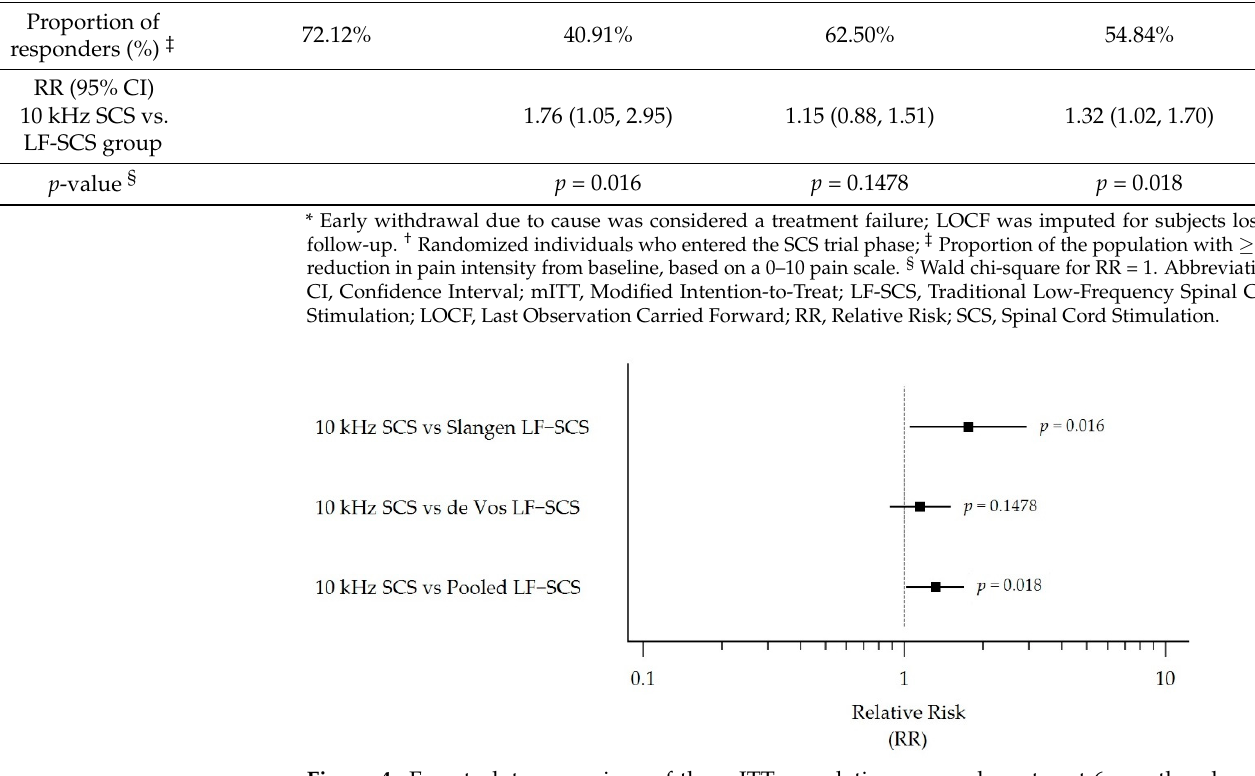
Figure 4. Forest plot comparison of the mITT population responder rates at 6 months, showing RR with 95% CI. The mITT comprised randomized individuals who entered the SCS trial phase. Abbre- viations: CI, Confidence Interval; LF-SCS, Traditional Low-Frequency Spinal Cord Stimulation; mITT, Modified Intention-to-Treat; RR, Relative Ratio; SCS, Spinal Cord Stimulation. Table 4. Comparison of the permanent implant population responder rates at 6